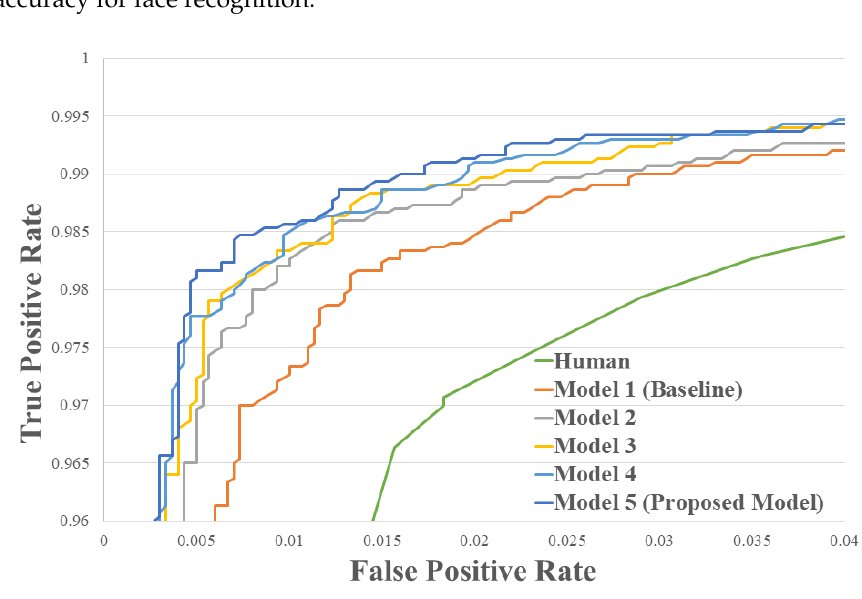
Figure 3. The ROC curve of different models on the LFW